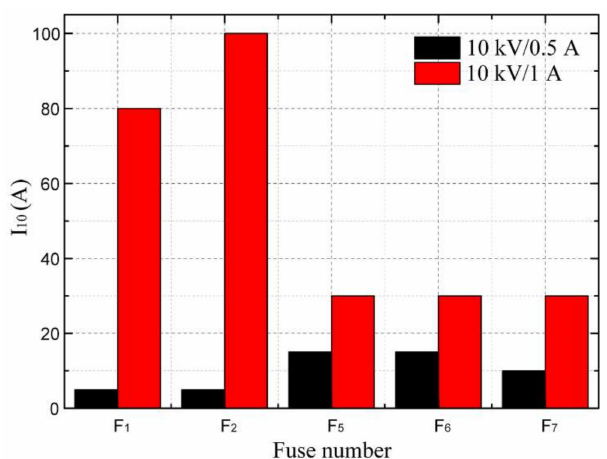
Figure 8. Highest impulse current amplitude borne by 10 kV fuses.